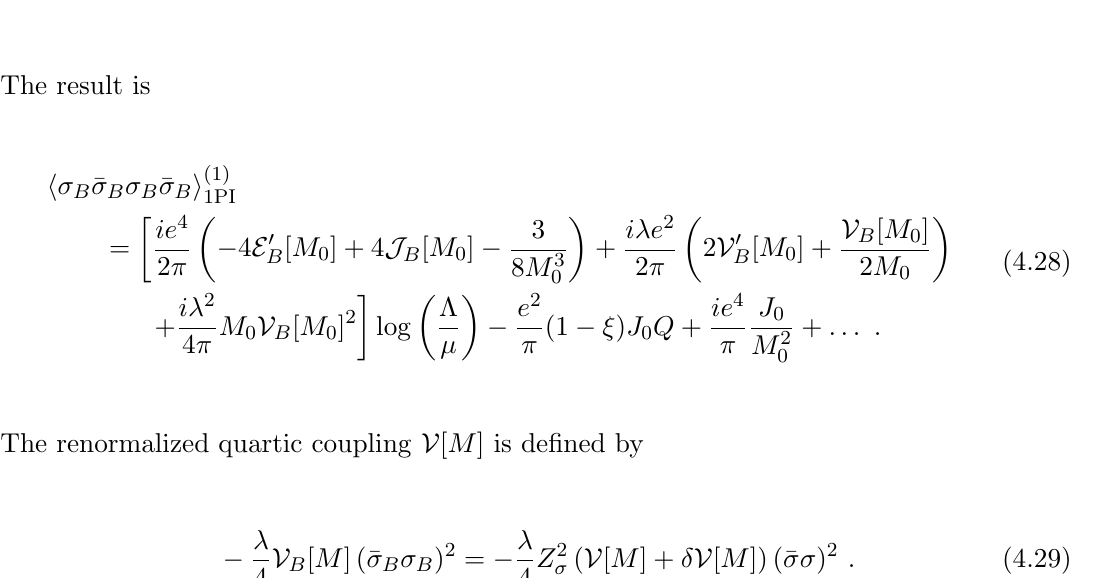
Figure 5. Corrections to the four-point function of (cid:27)